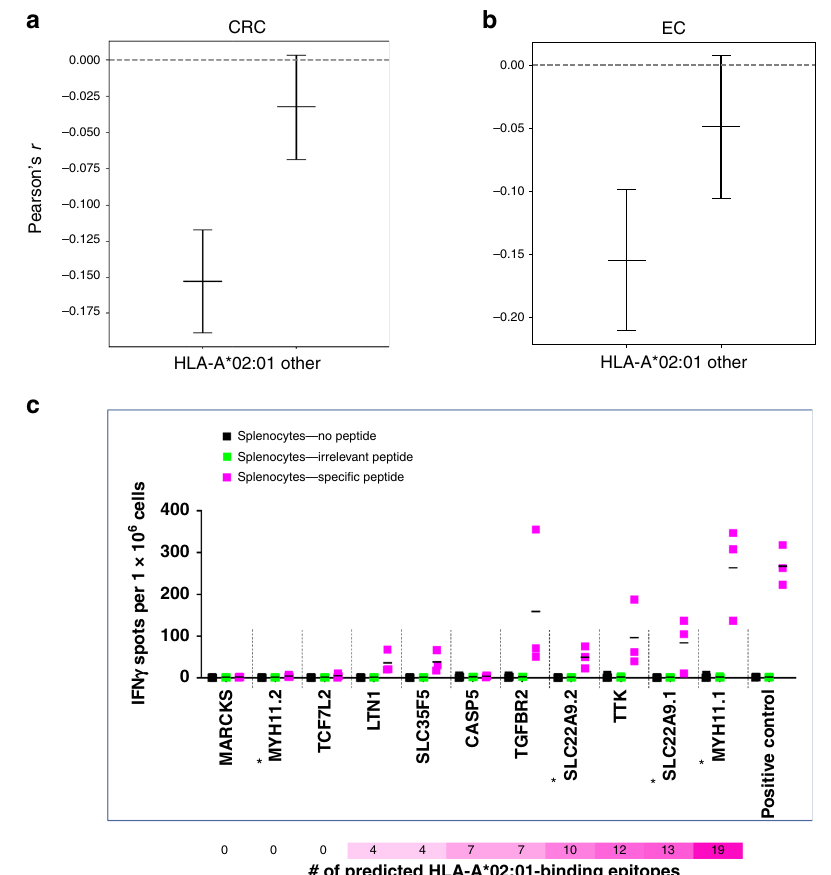
Fig. 5 HLA-A*02:01-speci fi c analyses. Correlation between the probability of at least one putative binder truly binding to HLA-A*02:01 within an M1 frameshift peptide and the respective M1 mutation rate in B2M -wild-type HLA-A*02:01-positive and HLA-A*02:01-negative CRC ( a ) and EC ( b ). The Pearson ’ s r from the correlation test is shown on the y axis, while the different groups of tumors are shown on the x axis. Centers indicate Pearson ’ s r , whiskers indicate 95% con fi dence intervals. A highly signi fi cant inverse correlation was observed showing r = − 0.15, p = 4.4 × 10 − 16 at n = 34 HLA- A*02:01-positive CRCs with all parameters kept from Fig. 4d. For n = 37 HLA-A*02:01-negative CRCs (other), signi fi cance did not persist at p = 0.29. Similarly, a signi fi cant inverse correlation between HLA-A*02:01-binding scores and mutation frequency was detected for HLA-A*02:01-positive MSI EC ( n = 13, r = − 0.15, p = 0.00002) but not for HLA-A*02:01-negative MSI EC ( n = 14) (see also Supplementary Fig. 8c, d). c Cellular immune response of M1 frameshift peptides in HLA-A*02:01-expressing A2.DR1 mice. IFN ɣ ELISpot was performed with splenocytes from immunized A2.DR1 mice ( n = 3) re- stimulated with the respective, speci fi c M1 frameshift peptides LTN1, MARCKS, SLC22A9, SLC35F5, MYH11, TTK, TCF7L2, CASP5 (magenta), irrelevant peptide (green), or no peptide (black) as controls. Long frameshift peptides SLC22A9 and MYH were synthesized in two parts (split frameshift peptides are marked by asterisks), with the N-terminal peptide labeled 1 and the C-terminal peptide labeled 2. Each dot represents the number of IFN ɣ spots per 1 × 10 6 cells for one mouse. Mean values are indicated by horizontal lines. The M1 frameshift peptides are sorted according to the number of predicted HLA- A*02:01 ligands (IC 50 < 500 nm). Source data are available as a Source Data fi